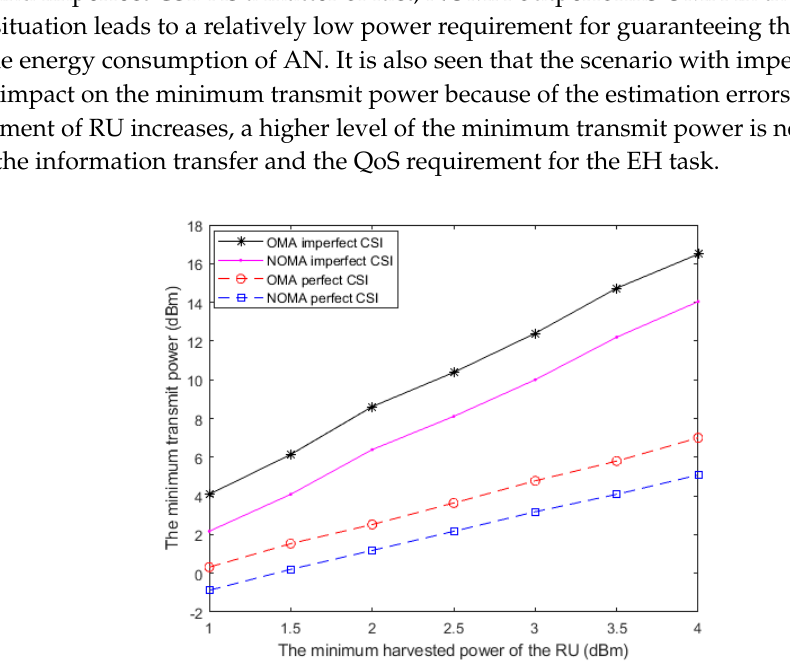
Figure 7. The minimum transmit power versus the minimum harvested power of the roaming users (RU) in the system with perfect and imperfect CSI.